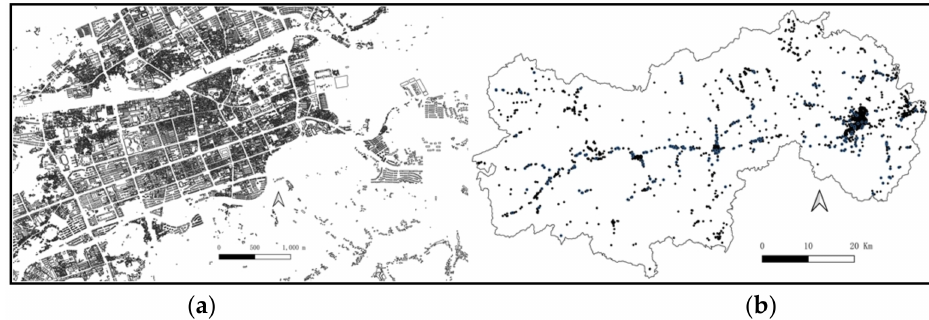
Figure 2. Subsets of ( a ) building and ( b ) POI data.